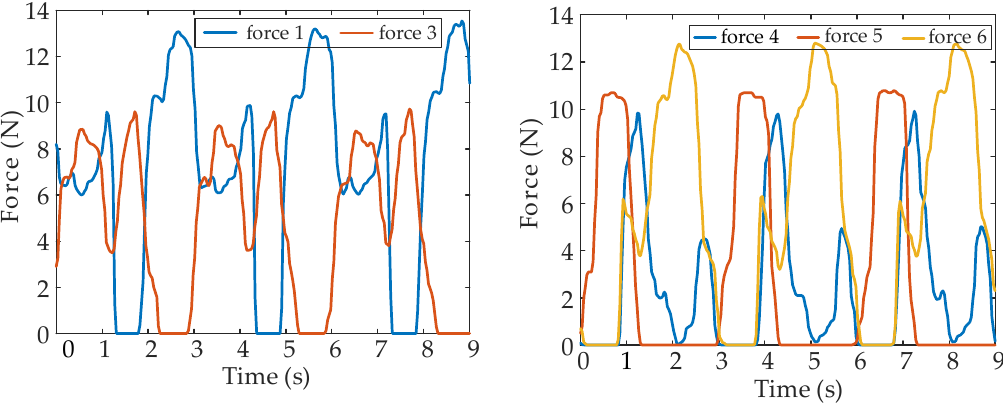
Figure 27. A set of snapshots of the walking experiment with leg 2 fault. Appl. Sci. 2020 , 10 , x FOR PEER REVIEW